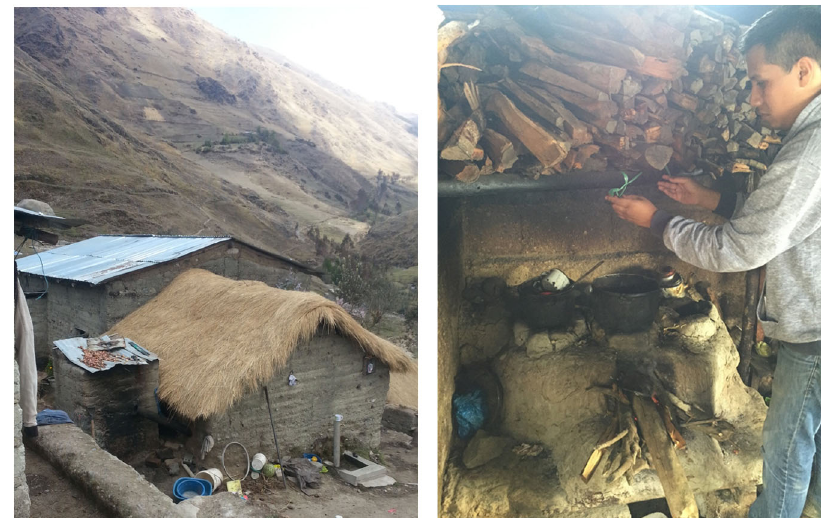
Fig. 2 Community housing with different types of roofs (zinc corrugated roo fi ng sheets and “ Ichu ” peruvian natural fi ber) and indoor cooking stove. This fi gure shows the current conditions of the communities, as the houses were built without any technical supervision, there are holes in the walls, doors, windows and